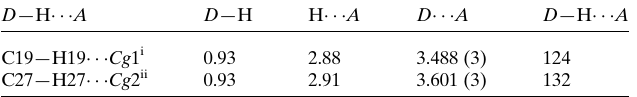
Table 1 Hydrogen-bond geometry (A˚ , (cid:3) ). Cg 1 and Cg 2 are the centroids of atoms C7–C12 and N1/C2/C3/N4/C5–C7/ C12–C14, respectively.